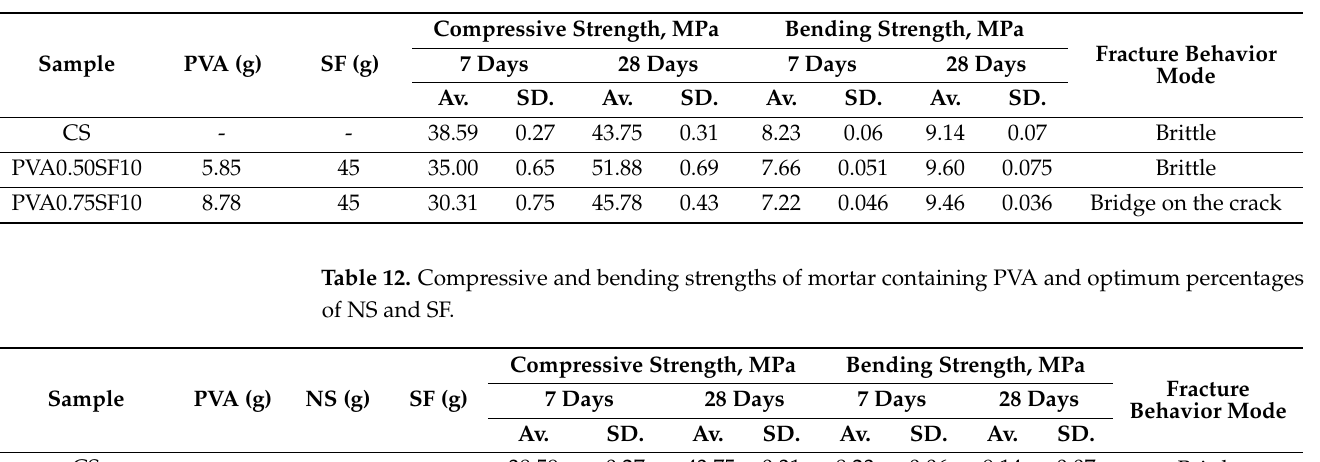
Table 11. Compressive and bending strengths of mortar containing PVA and optimum percentages of SF.